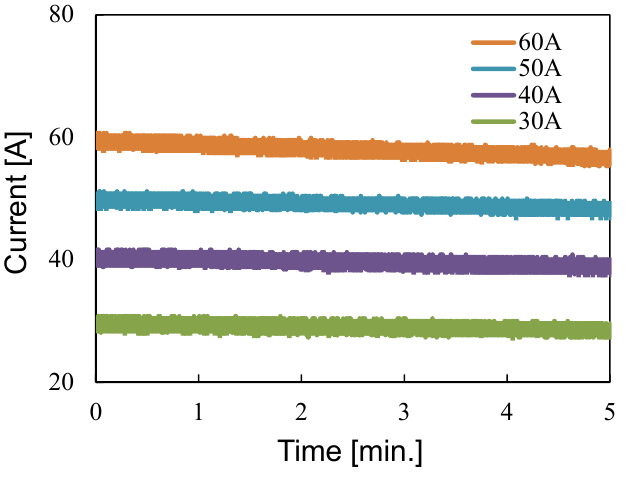
Figure 4. Relationship between persistent current and time for various initial currents of 30, 40, 50 and 60A.